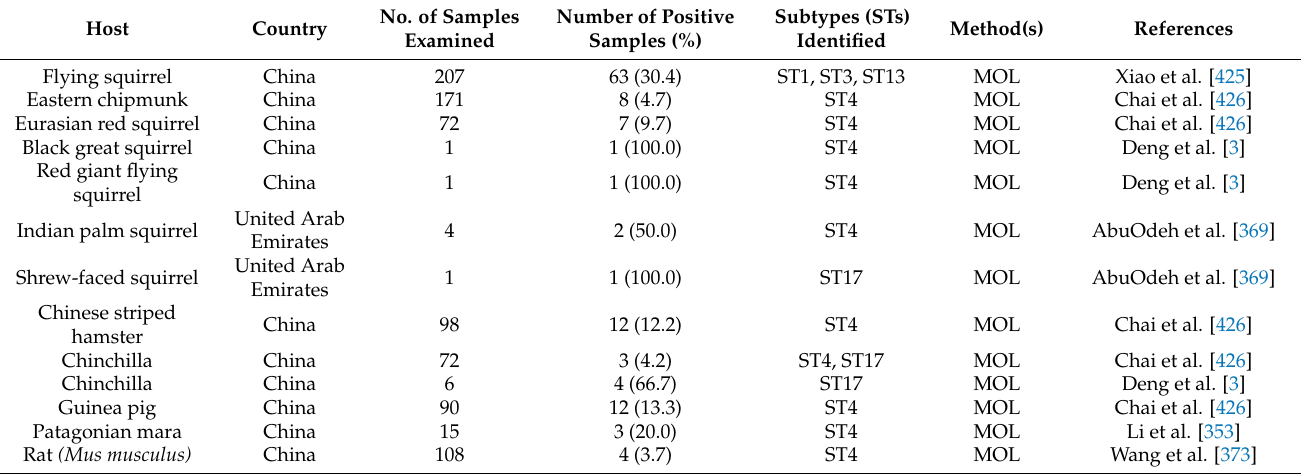
Table 13. Prevalence and subtype distribution of Blastocystis spp. in rodents in Asia